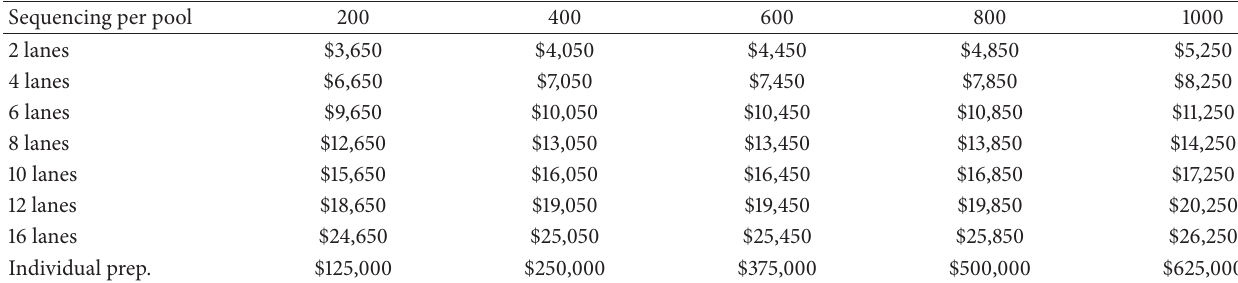
Table 3: Pooled and individual sequencing